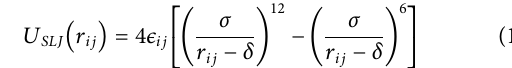
Frontiers in Physics |